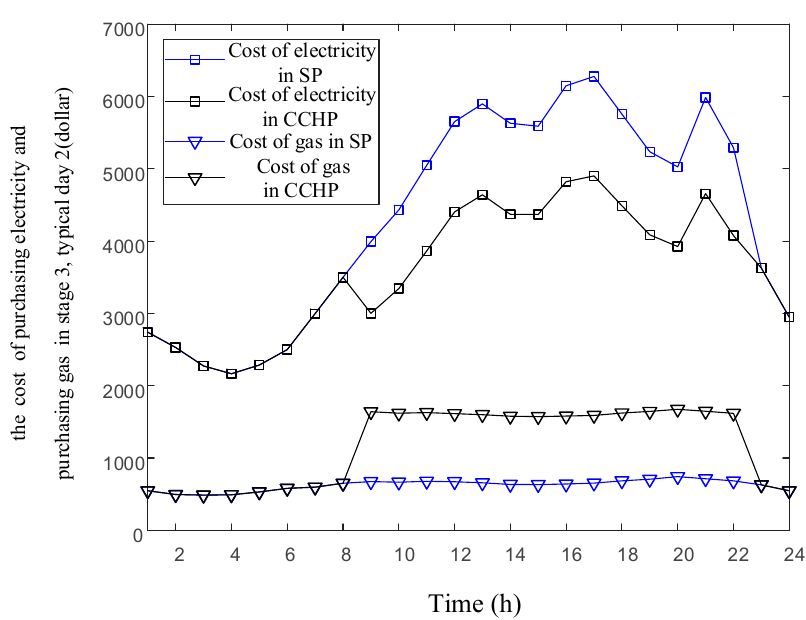
Figure 12. Cost curves of purchasing electricity and purchasing gas for different cases in stage 3, typical day 2.